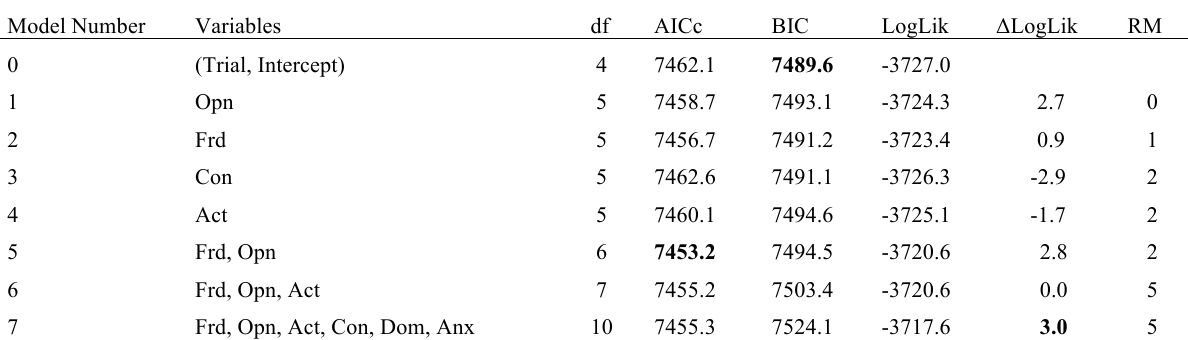
Table 6 Model Selection Results for Regressions Predicting Rewarded Trials Model